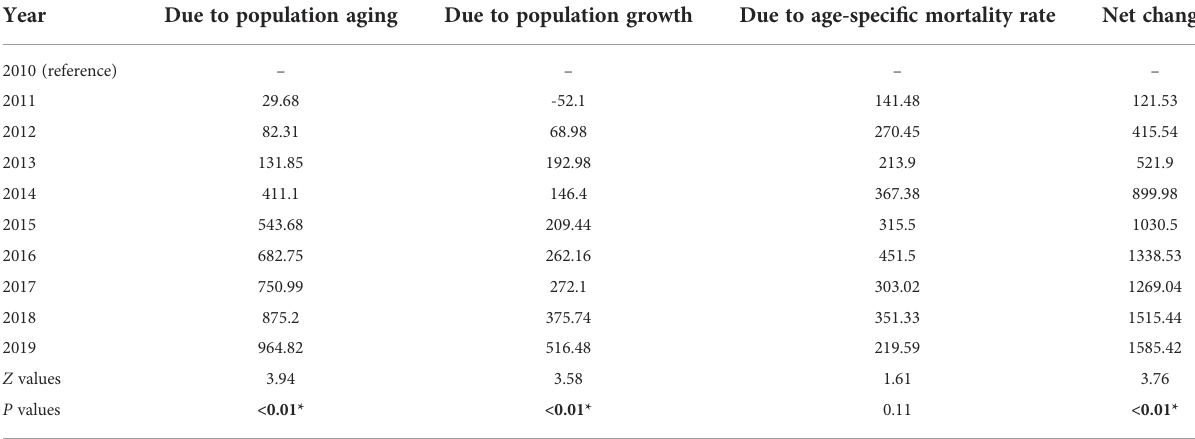
TABLE 3 Contribution of changes in population aging, population growth, and age-speci fi c mortality rate of lung cancer to variations of lung cancer deaths in Wuhan, 2010-2019.